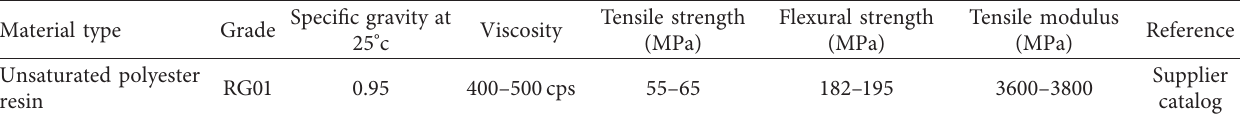
Table 3: Matrix material property.